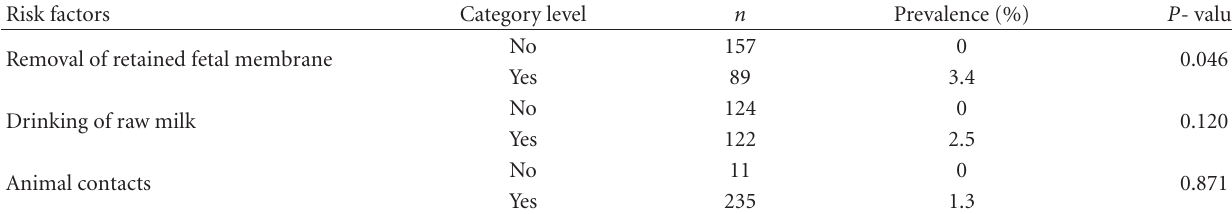
Table 6: Association of Brucella seropositivity with some risk factors in humans of Western Tigray, North Western Ethiopia, October 2007 to February